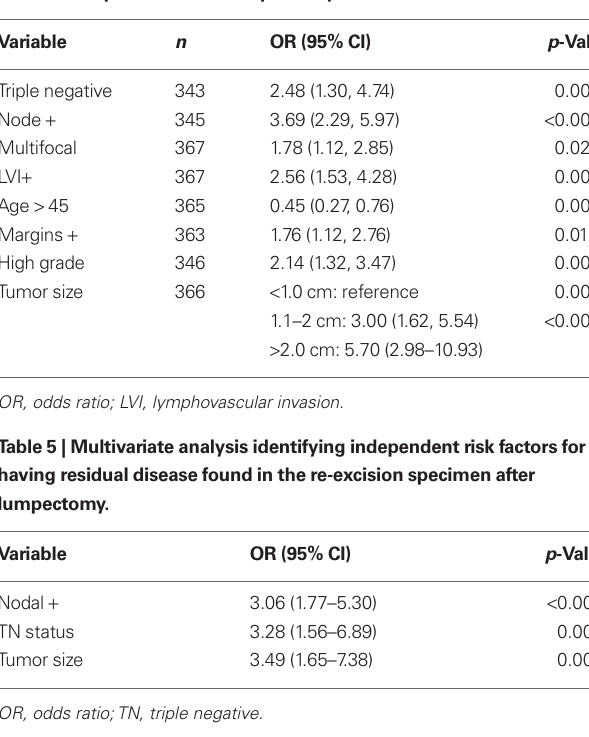
Table 4 | Univariate analysis relating risk factors associated with local recurrence risk with incidence of residual disease found in the re-excision specimen after lumpectomy.